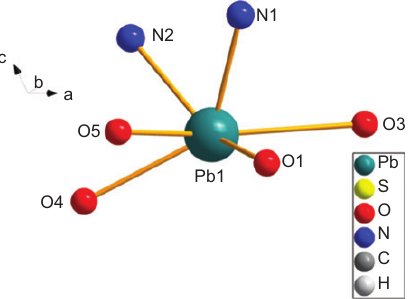
Figure 2 Geometry of the Pb atom.